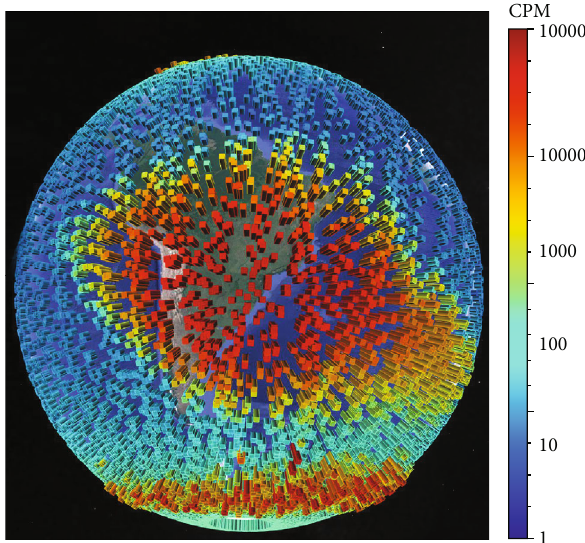
Figure 11: Radiation data measured by an onboard detector combined with the GPS position. 1 CMP ~ 2.10 -4